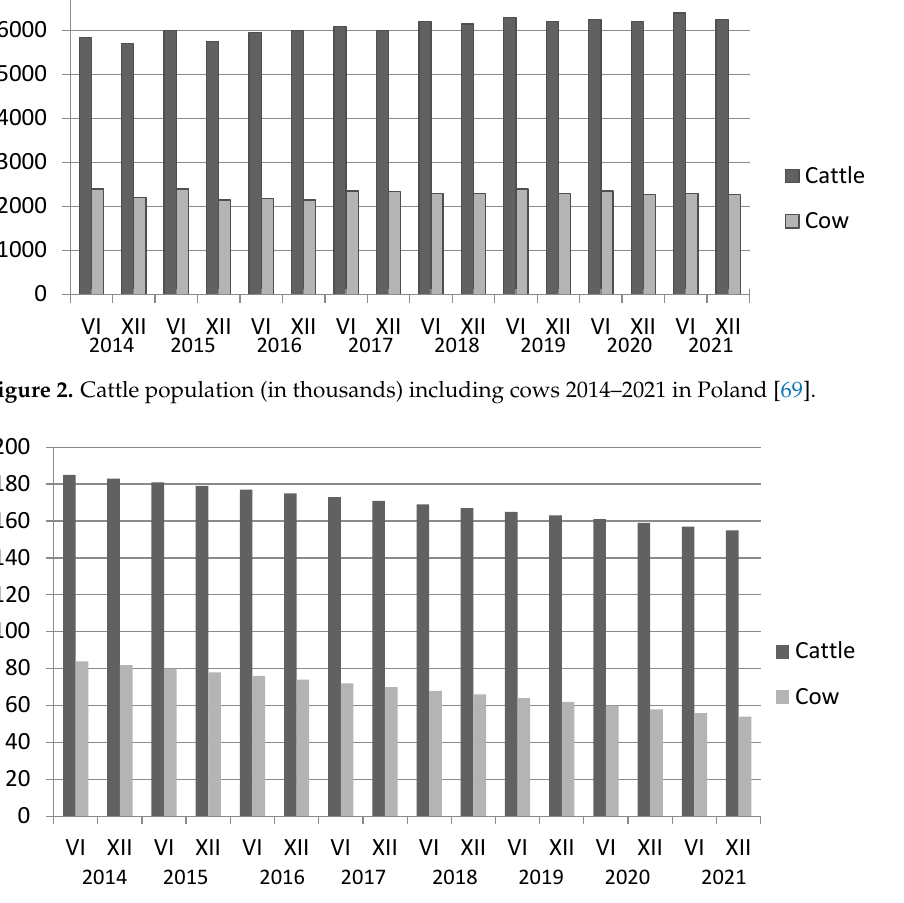
Figure 3. Cattle population (in thousands) including cows 2014–2021 in Germany Figure 3 . Cattle population (in thousands) including cows 2014–2021 in Germany [70].